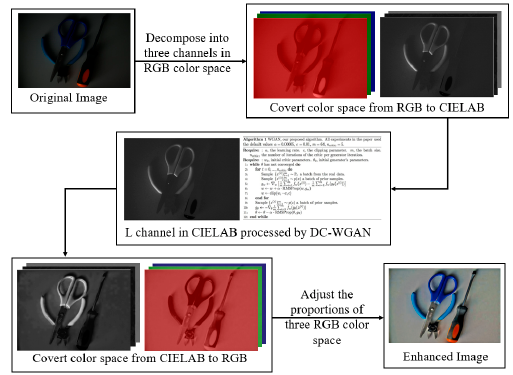
Figure 3. Flow chart of the proposed algorithm.